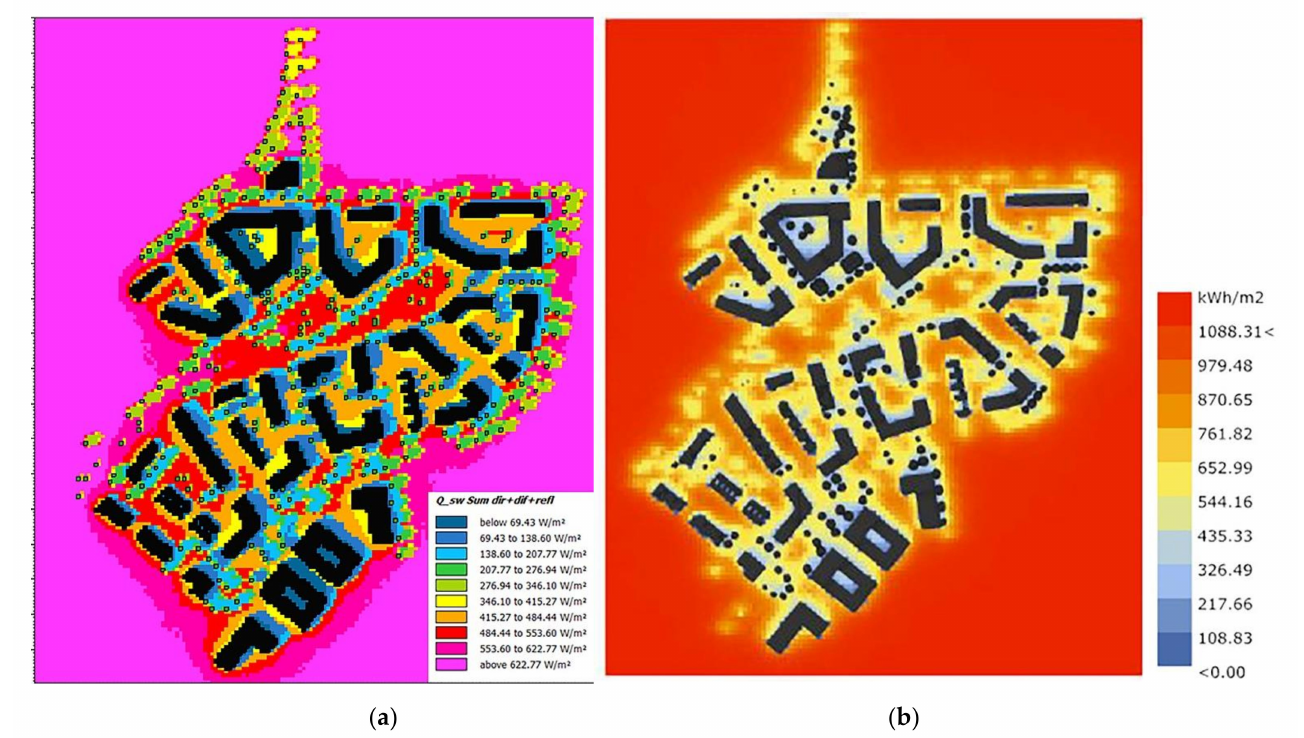
Figure 3. Comparison of radiation simulations: ( a ) ENVI-met; ( b ) Ladybug (source: authors).